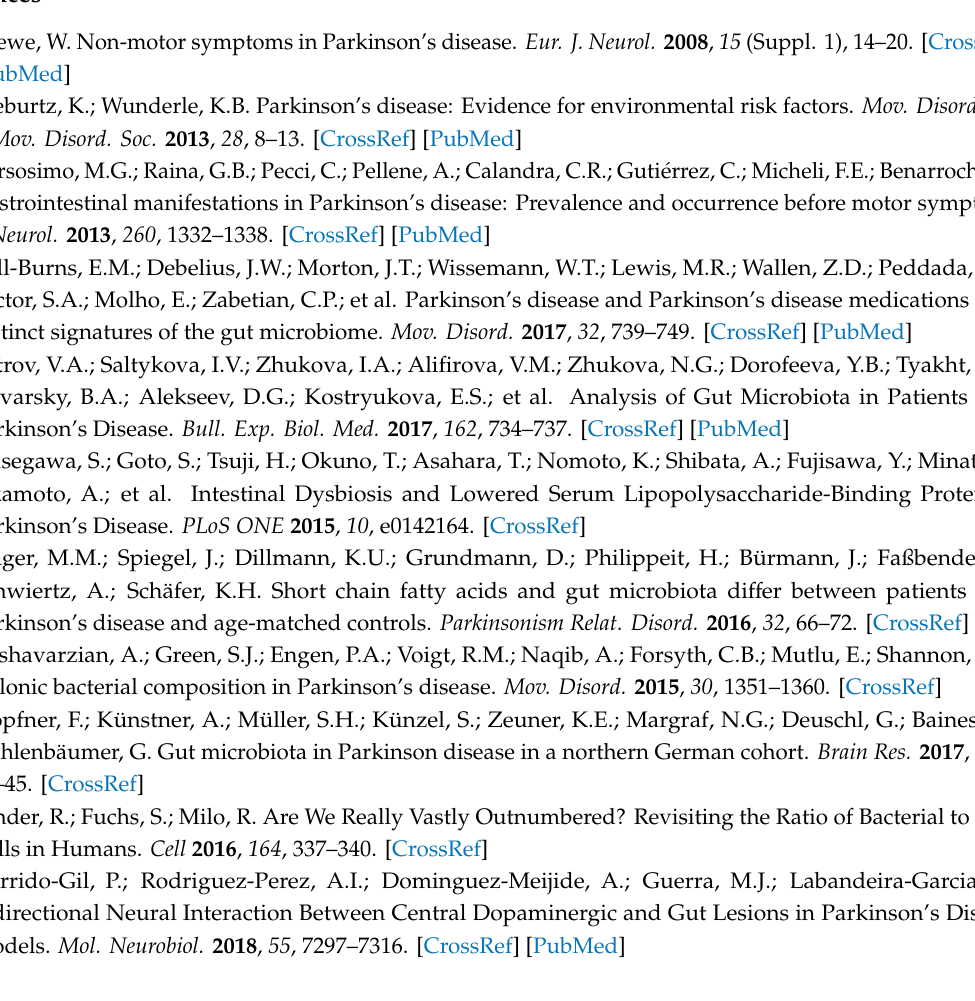
Figure S1: Relative abundance of Clostridiaceae before and after therapy (* p < 0.05; ** p < 0.01). Figure